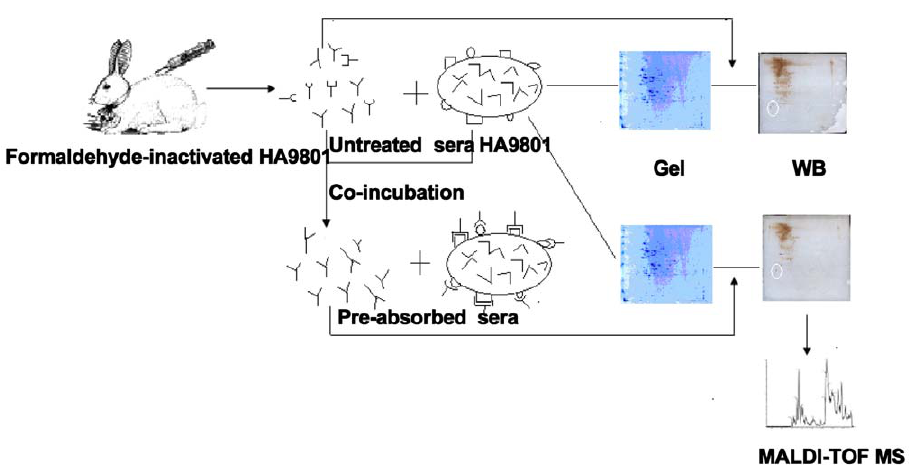
Figure 1. Schematic diagram of the surface protein detection assay. One sample of the S. suis -derived antiserum was pre-absorbed with whole-cell S. suis to remove the antibodies that recognize outer surface proteins (‘‘pre-absorbed’’). Then, untreated and ‘‘pre-absorbed’’ antisera were used to probe 2-DE gels of S. suis proteins. Spots that appear in the blot probed with untreated antiserum, but that were absent from the blot probed with ‘‘pre-absorbed’’ antiserum, were evaluated to identify the surface